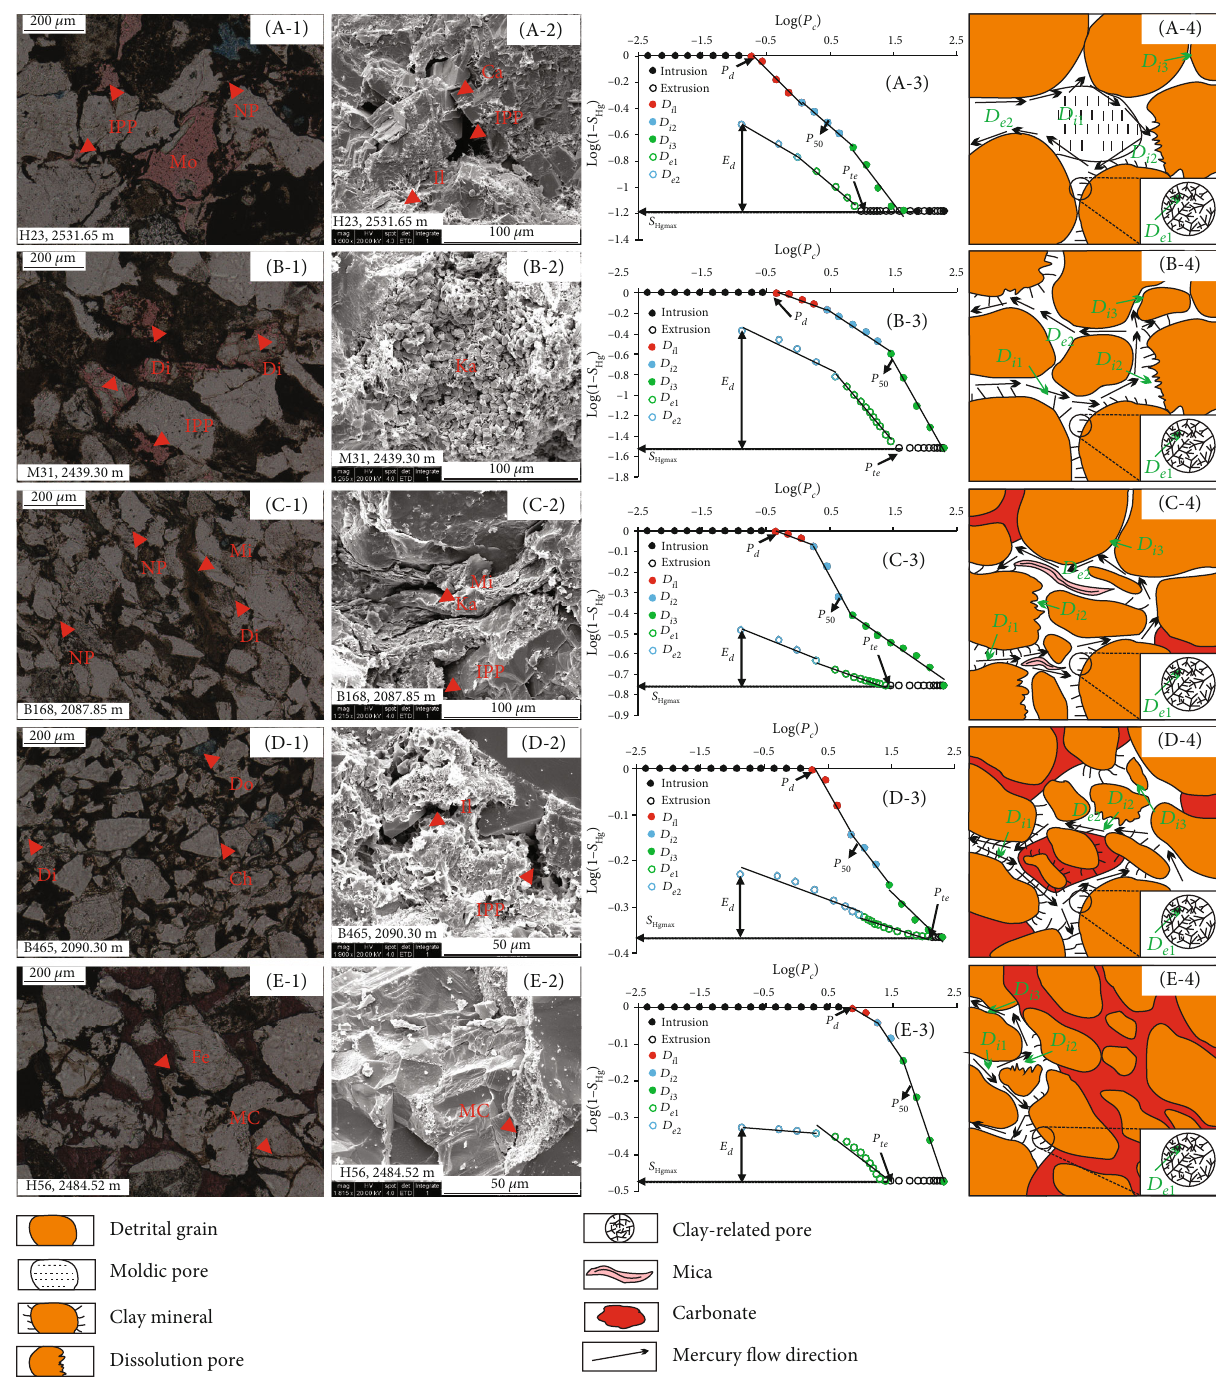
Þ vs. log ð 1 ‐ S Þ using HPMIP and schematic diagrams of HPMIP- c Hg